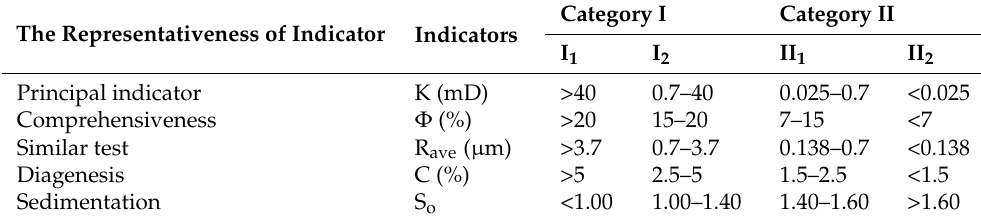
Table 9. Comprehensive classification of the pore structure of the deep-mine